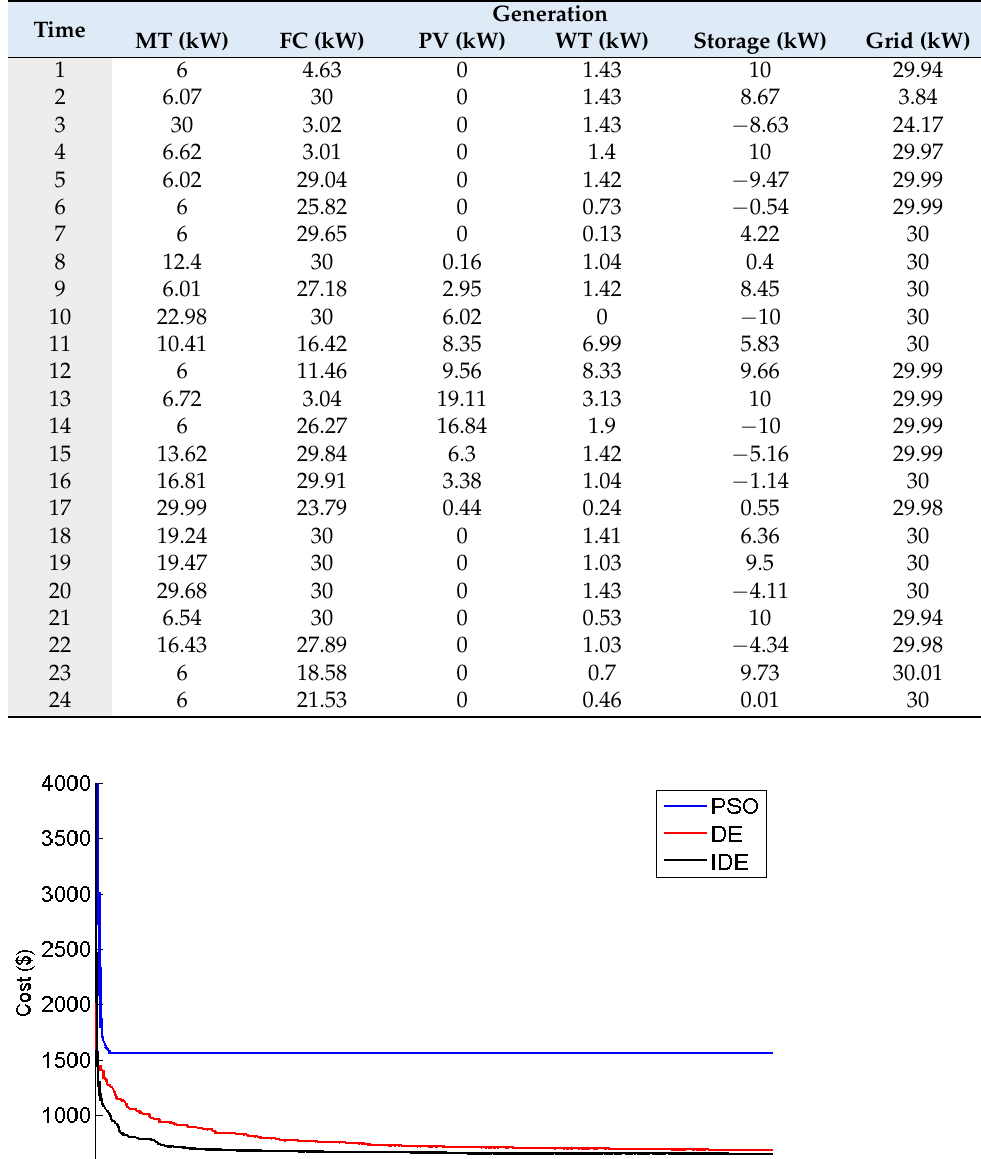
Table 10. Power distribution for reducing pollution and considering the limitations of the upstream network exchange.